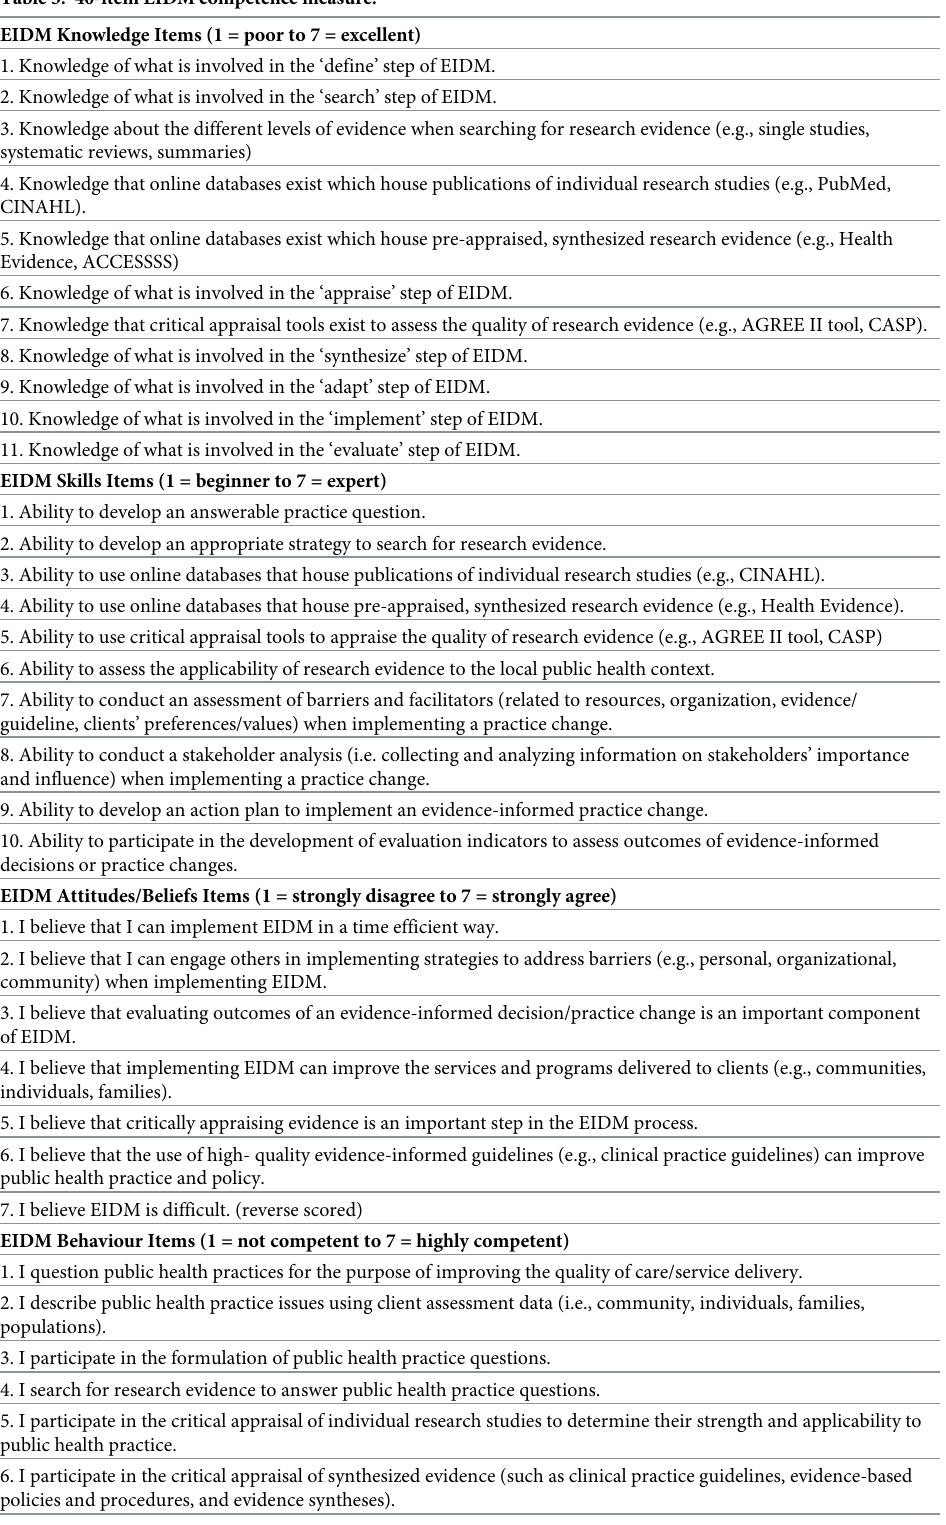
Table 3. 40-item EIDM competence